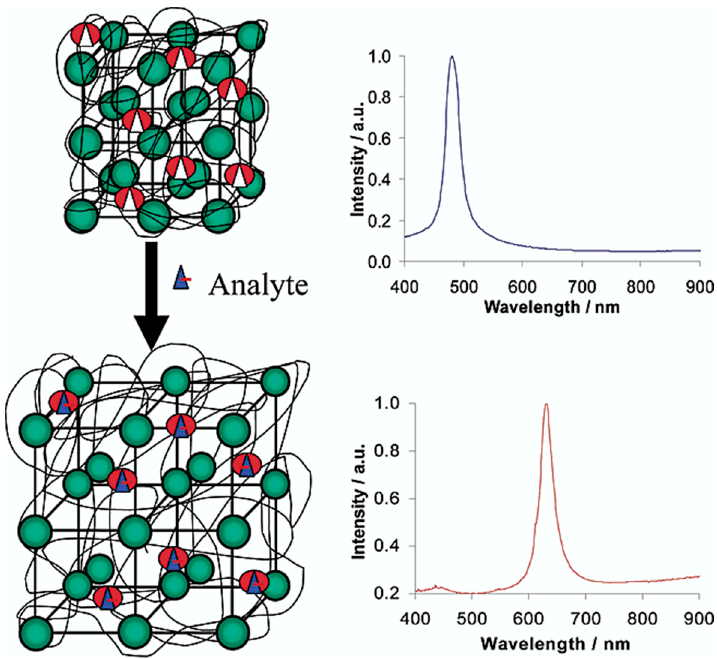
Figure 11. ( Left ) PCCA photonic crystal sensing materials consist of an embedded CCA surrounded by a polymer hydrogel network that contains boronic acid moieties (red circles). The imbedded PS-particles (green circles) diffract light of a wavelength determined by the array lattice constant. ( Right ) The change in diffracted wavelength resulting from the hydrogel volume swelling upon interaction with glucose as analyte [94]. Copyright 2003 American Chemical Society.